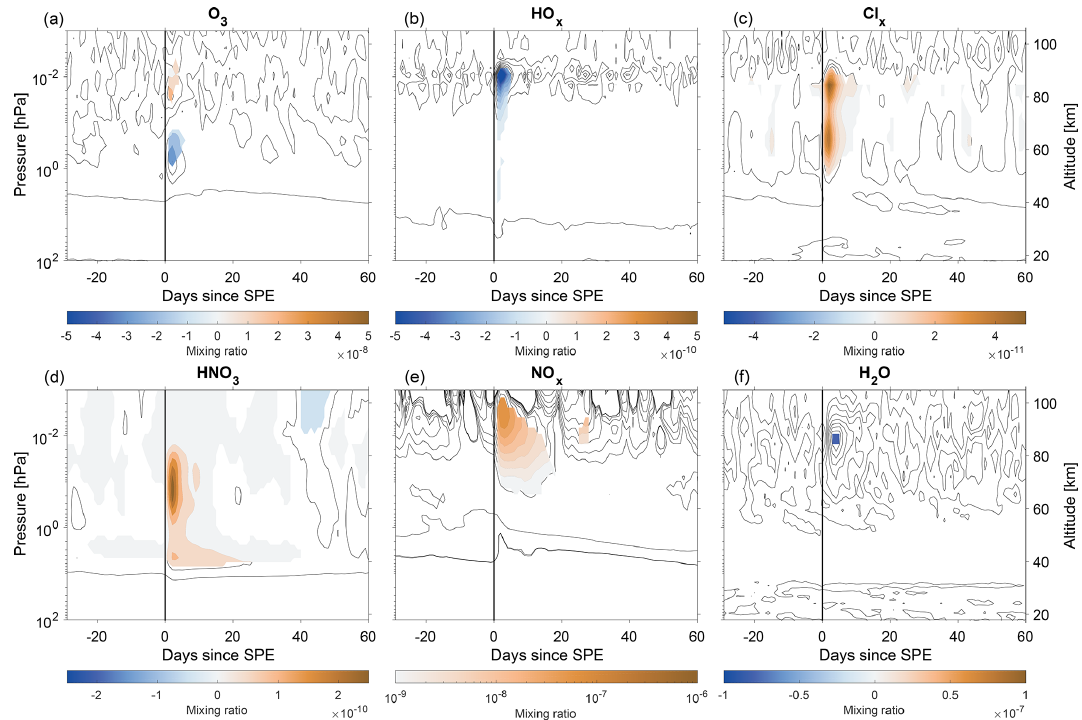
Figure 7. Area-weighted southern polar cap averages (latitude > 60 ◦ S) of composite means of (cid:100) WD – (cid:100) REF (see Fig. 5). The x axis shows the number of days before and after the event (day 0, solid black line) and the y axis pressure levels in the model (hPa, a, d ) and approximate altitude (km, c, f ). Note that the color scale for NO x panel is logarithmic, and all contours shown in that panel indicate positive